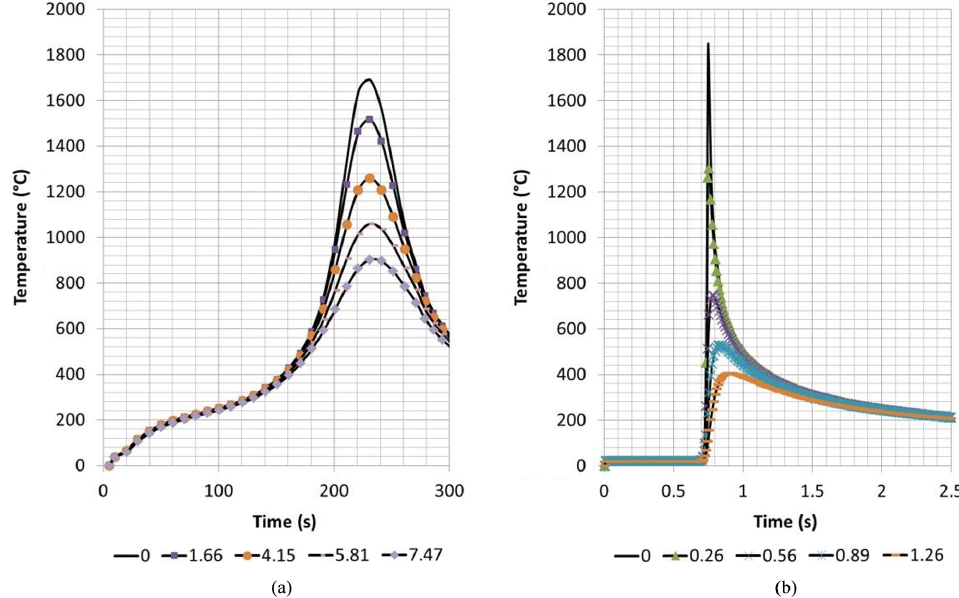
Figure 3. Calculated temporal evolution of the temperatures during (a) TIG and (b) laser welding. The numbers on the right represents the distance from the weld